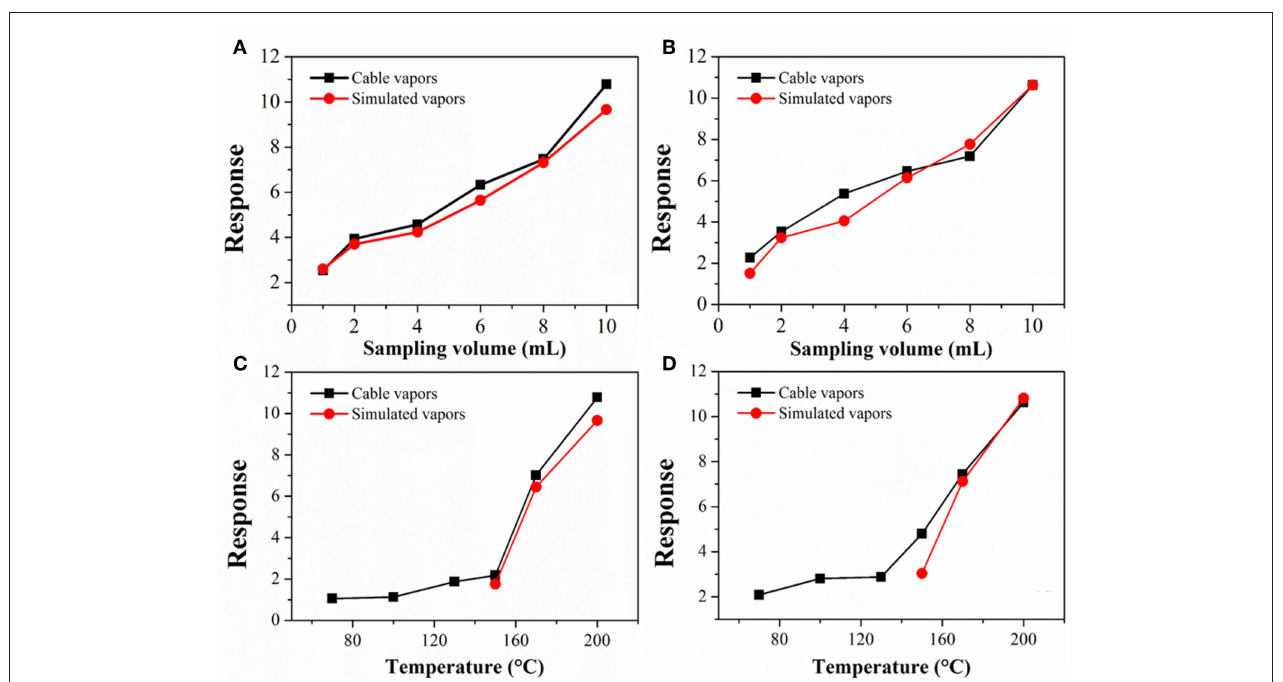
Frontiers in Materials |